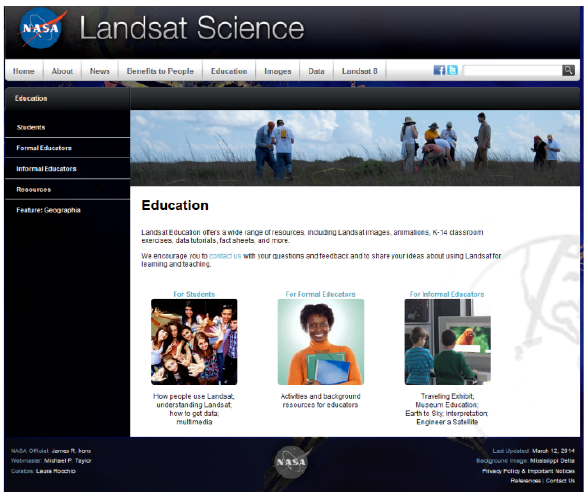
Figure 1: NASA education resources